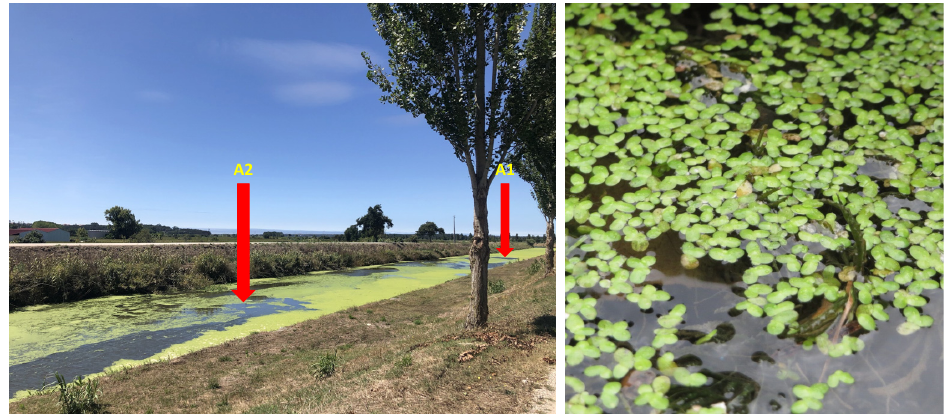
Figure 2. View of Lis River (left panel) illustrating the presence of Lemna minor at the adult stage in the study area (5 August 2021). This section of the river shows a composite cross-section, and the water surface width is approximately 25 m. The red arrows give the approximate location of the center of the observed areas A1 and A2 (see the text for details). A zoom view of the aquatic weed is shown on the right panel.